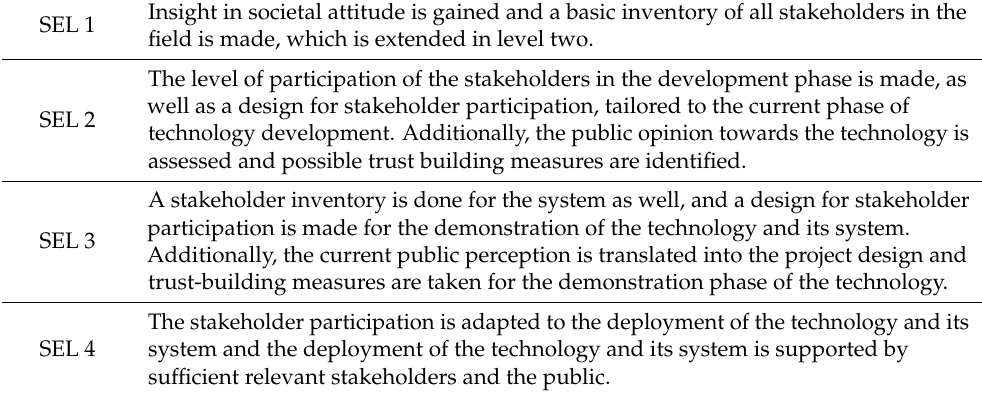
Table 5. Dimension 2: stakeholder involvement.